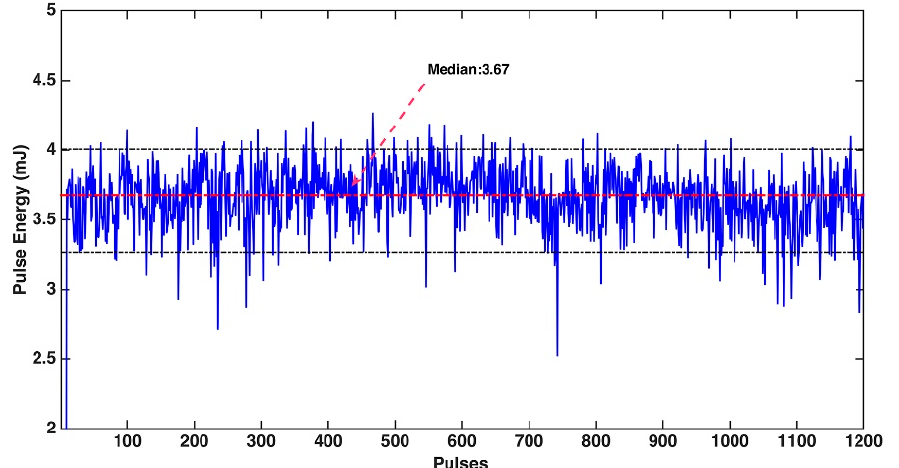
Figure 6. Pulse energy fluctuation with time. The intensity and position fluctuations come from the origin of SASE. The common fluctuations are typically 10% but sometimes as high as 30%.